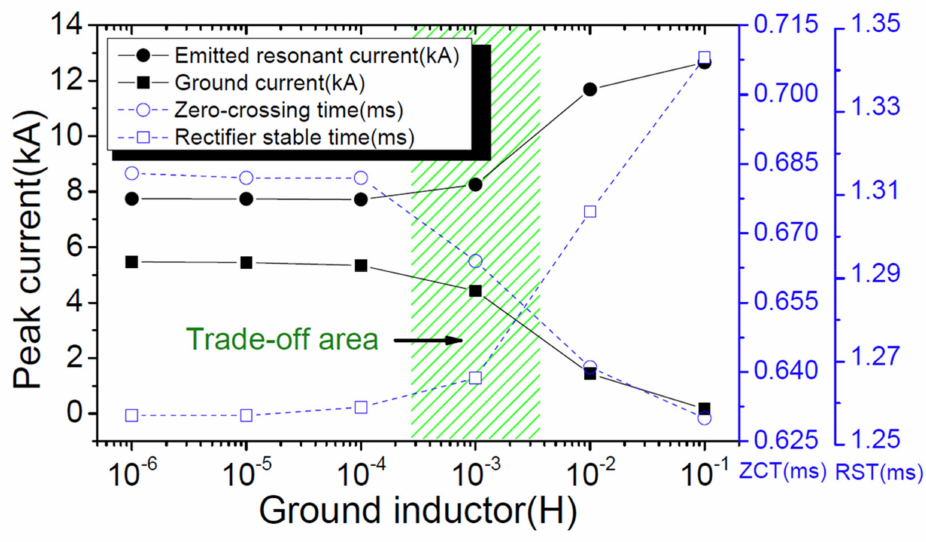
Figure 7. The emitted resonant current, ground current, zero-crossing time (ZCT), and rectifier stable time (RST) depending on the ground